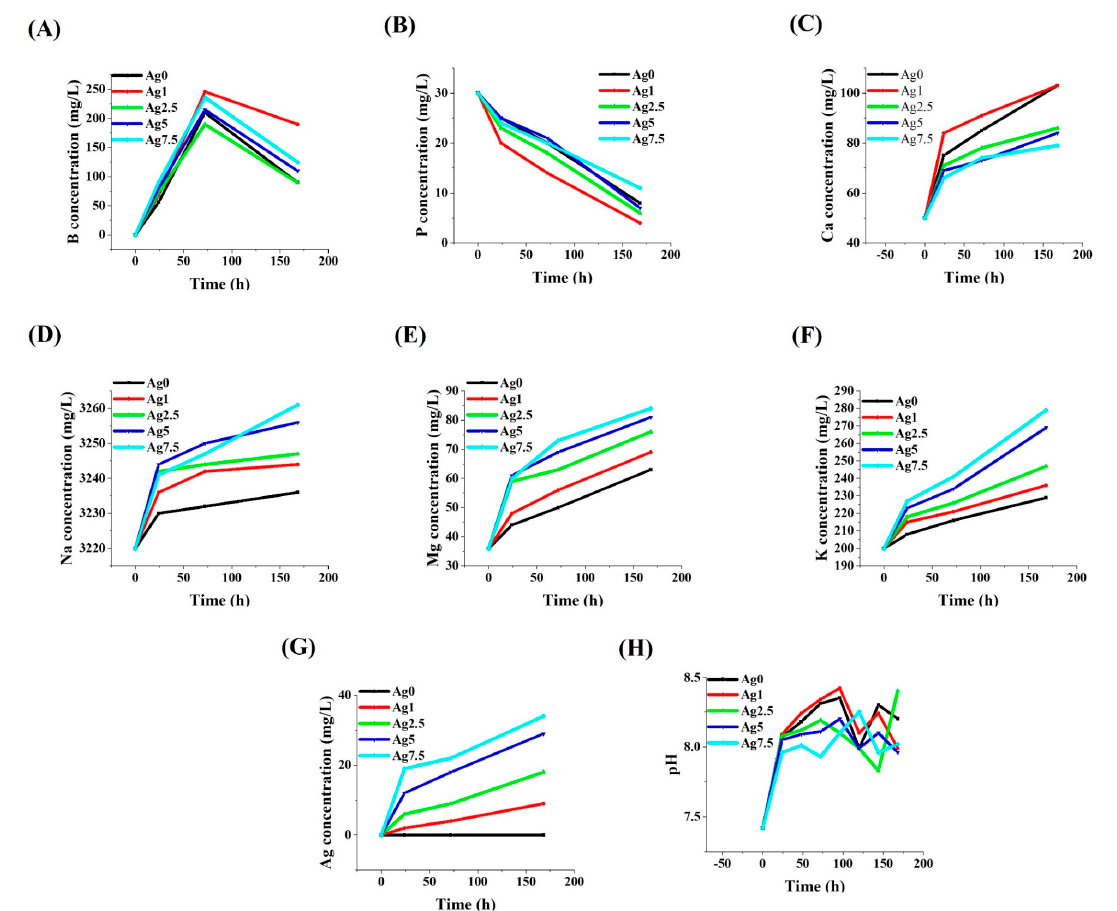
Figure 10. The release profile of different ions from Ag-free and Ag-doped MBGs ( A – G ), and the pH changes of the MBGs-containing SBF ( H ).